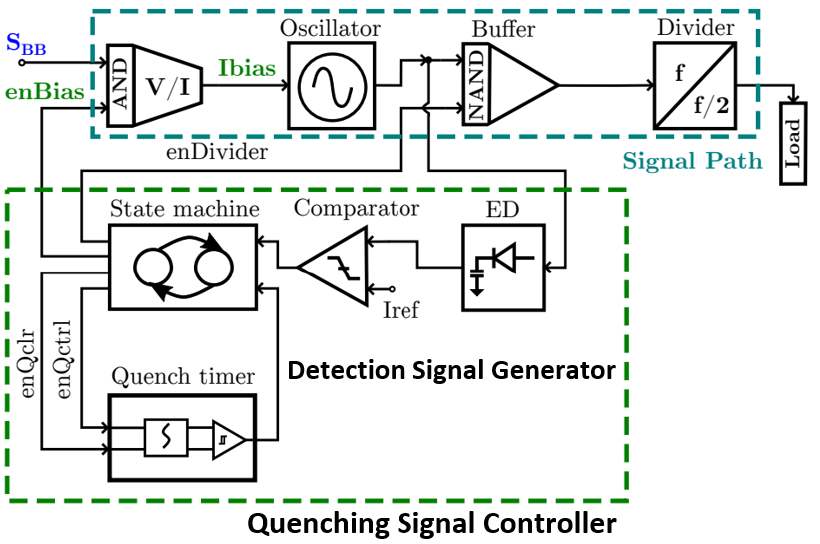
Figure 1. Block diagram of quenched transmitter with digital quenching signal controller.